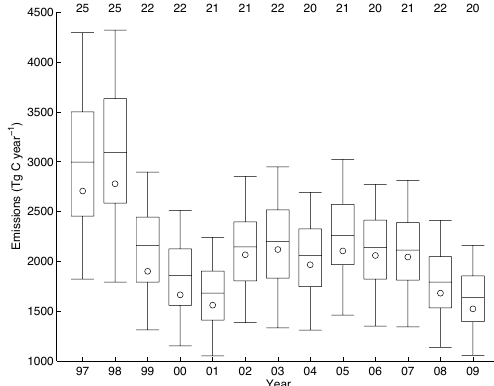
Fig. 14. Annual uncertainties expressed as the 5 th , 25 th , 50 th , 75 th , and 95 th percentiles of 2000 runs from a set of Monte Carlo simulations. Circles denote the estimates reported throughout the paper, which do not necessarily align with the 50 th percentiles due to truncation of several parameters in the Monte Carlo simulations. Numbers on the top of the plot indicate 1 σ uncertainties in annual fire emissions in percent of the median estimate from Monte Carlo simulations, assuming a Gaussian distribution. Note that uncertainties are larger on regional and monthly scales (Fig. S6).